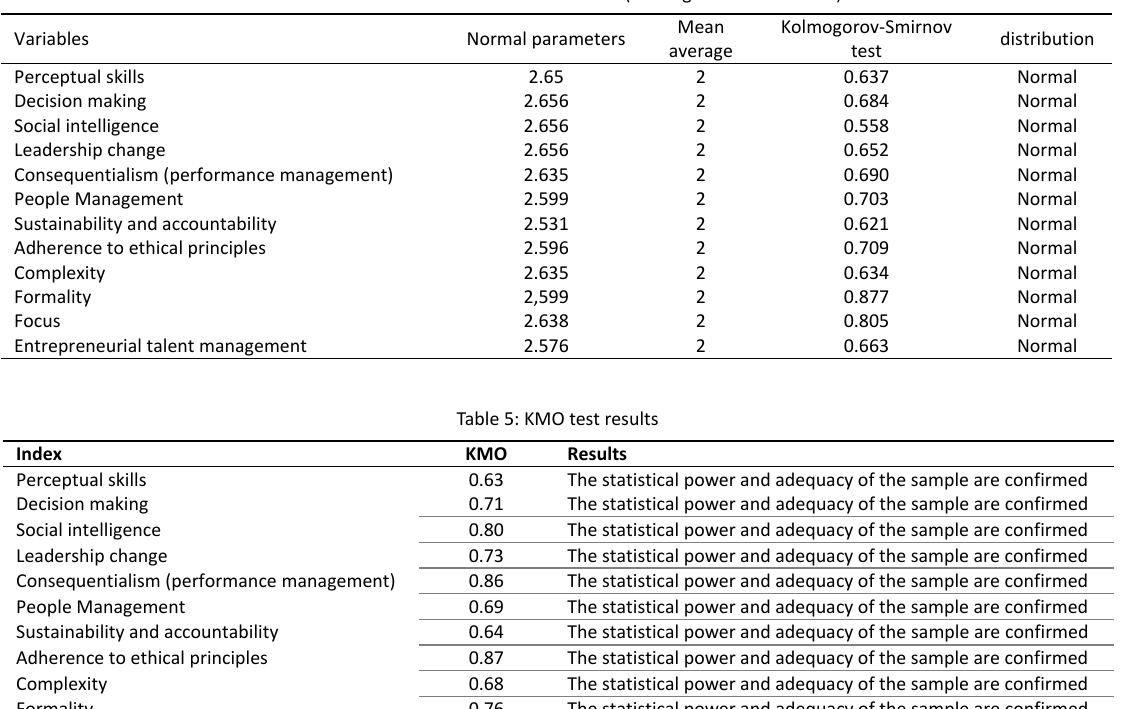
Table 4: Normalization of research variables (Kolmogorov-Smirnov test)